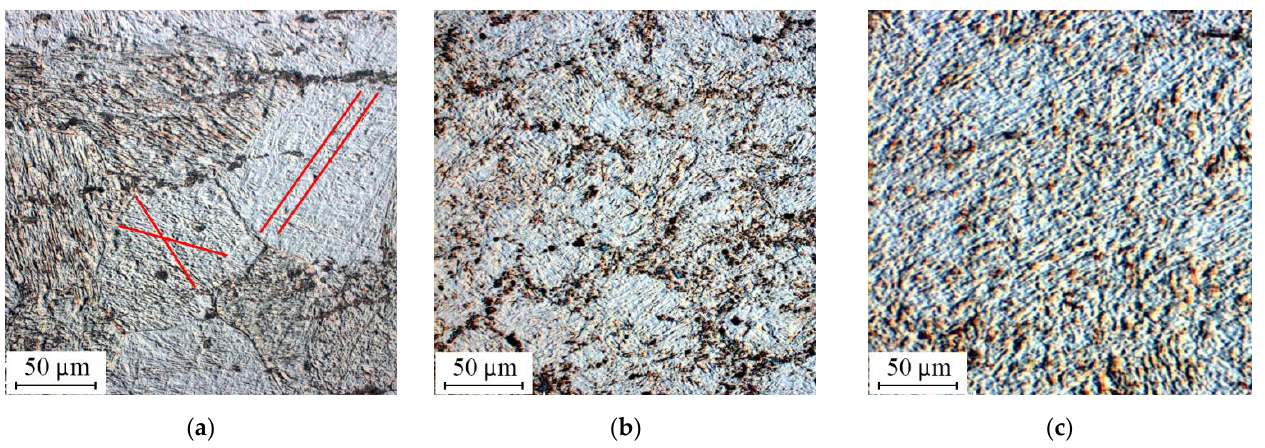
Figure 5. DIC images of Ti 49.8 Ni 50.2 before ( a ) and after abc pressing to e = 3.6 ( b ) and e = 9.55 ( c ).